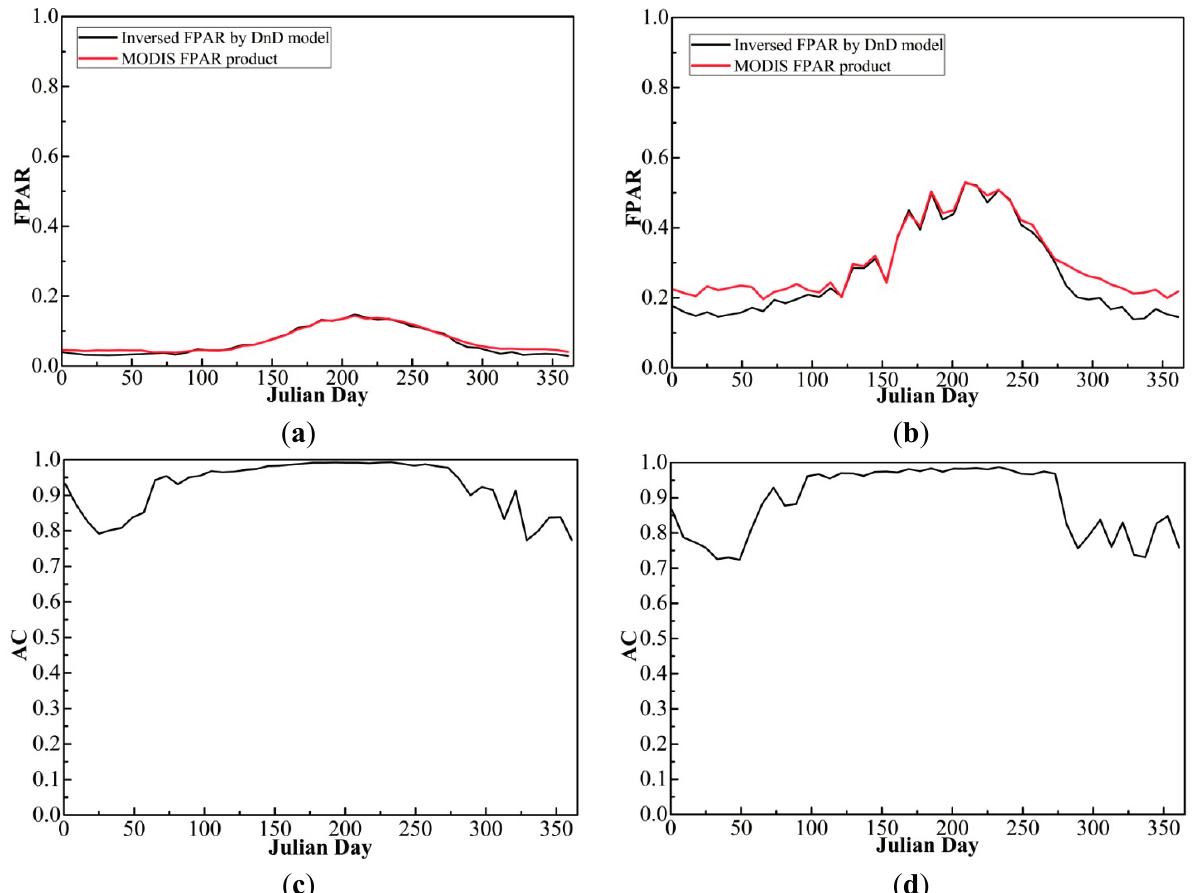
Figure 10. Temporal profiles of shrub and evergreen needleleaf forest land cover classes over the Heihe River Basin. ( a ) mean FPAR values of inversed FPAR by the DnD model and the MODIS FPAR product of shrub land cover; ( b ) mean FPAR values of inversed FPAR by the DnD model and the MODIS FPAR product of evergreen needleleaf forest land cover; ( c ) agreement coefficient (AC) of shrub land cover; ( d ) AC of needleleaf forest land